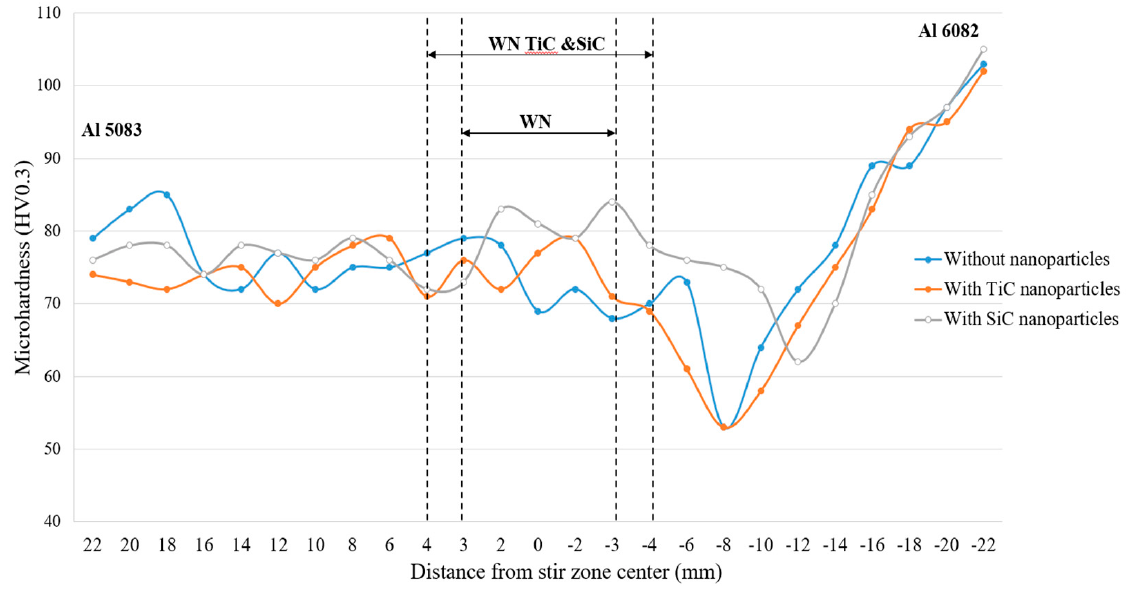
Figure 17. Microhardness distribution (2 mm under the surface) of the dissimilar Al joint reinforced with TiC nanoparticles, SiC nanoparticles and without nanoparticle addition.